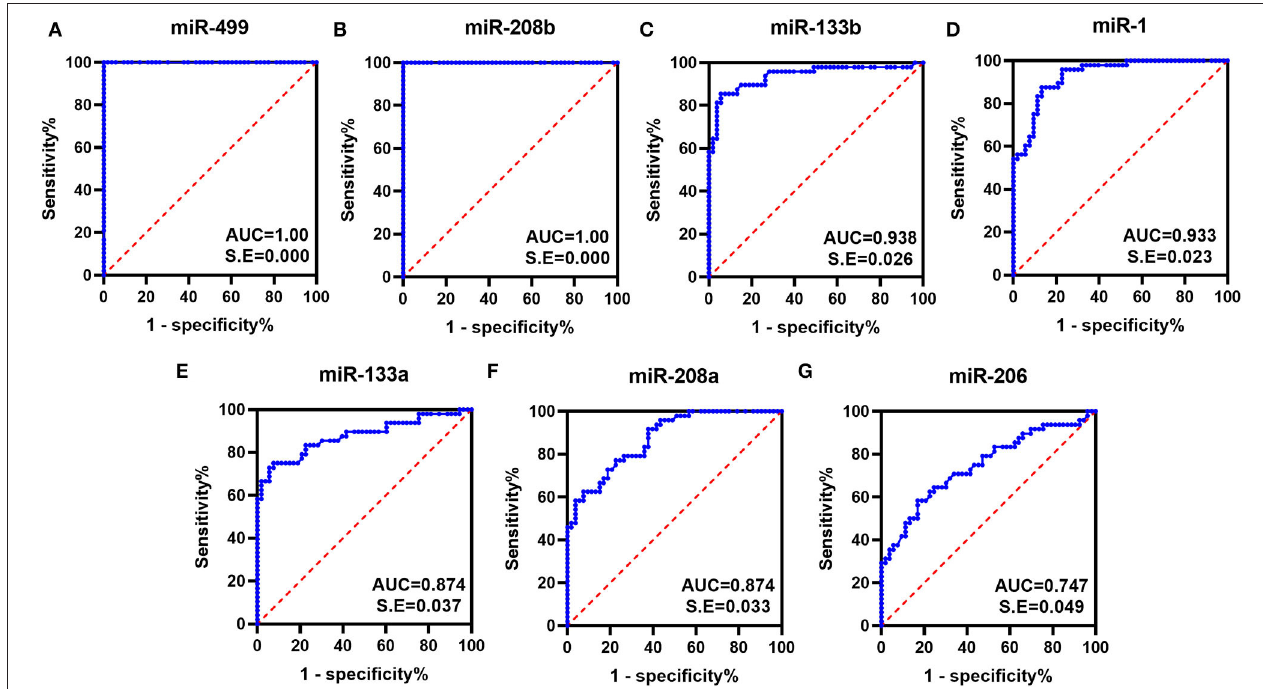
FIGURE 2 | ROC curves obtained for the myomiRs. ROC curves were plotted to evaluate the diagnostic performance of miR-499 (A) , miR-208b (B) , miR-133b (C) , miR-1 (D) , miR-133a (E) , miR-208a (F) , and miR-206 (G) . The AUCs were calculated for the measurement of discrimination accuracy. All had p- values < 0.05.